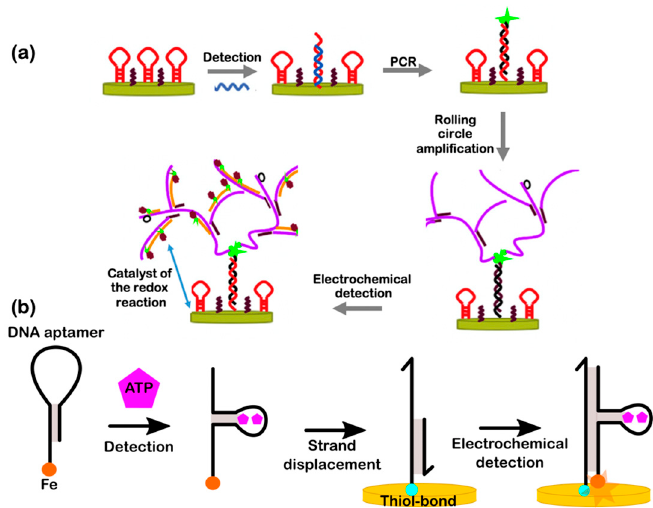
Figure 8. Hybrid DNA electrochemical biosensors: ( a ) By integrating programmable DNA sequences and active DNA systems on an existing electrochemical platform to detect biomarkers of interest by employing circular strand displacement polymerization and hybridization chain reaction amplification schemes; ( b ) Programmable DNA aptamers are immobilized on an electrochemical platform to sense the presence of ATP. Upon sensing the target molecule, the aptamer changes its structural conformation and hybridizes to the probe on the electrochemical surface, resulting in changes in electrochemical potential for signal detection. Adapted with permission from [160]. Copyright 2016,